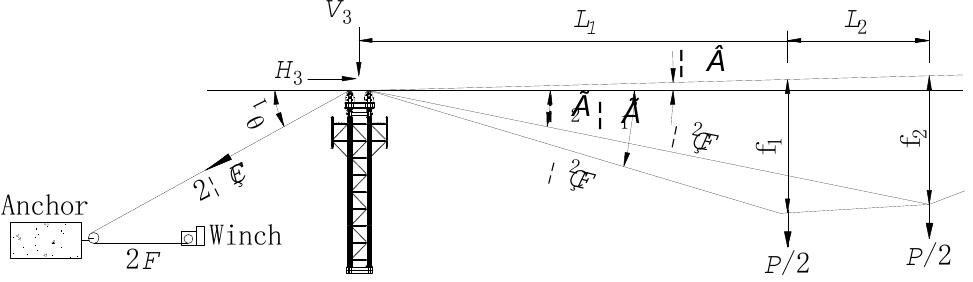
Figure 4. Calculation diagram of the acting force of lifting cable on tower.